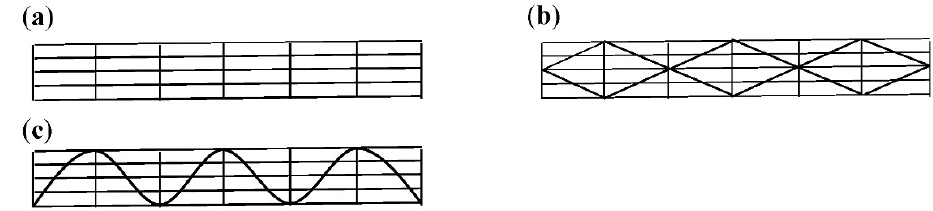
Figure 1. Types of multiwall polycarbonate sheets: ( a ) rectangular structure, ( b ) truss structure, ( c ) structure with an internal sine wave [15].